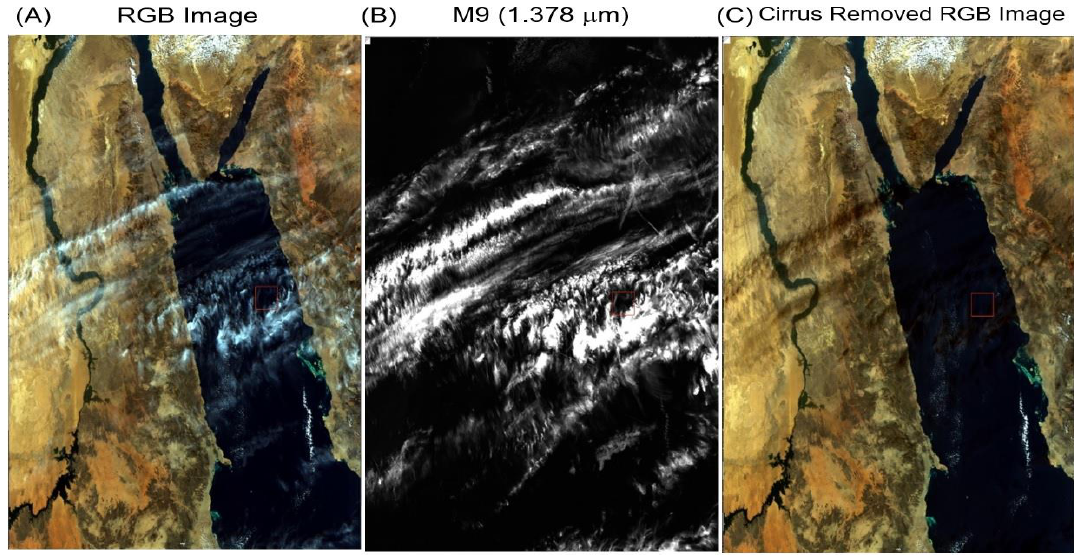
Figure 8. A portion of a VIIRS RGB image over Red Sea and nearby areas ( A ), the M9 band apparent reflectance image ( B ), and the cirrus-removed RGB image ( C ) [20]. reflectance image ( B ), and the cirrus-removed RGB image ( C )